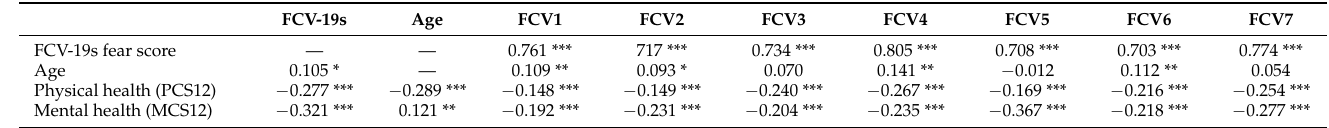
Table 3. Spearman’s correlations between age, COVID-19 fear and SF-12 summary scores.